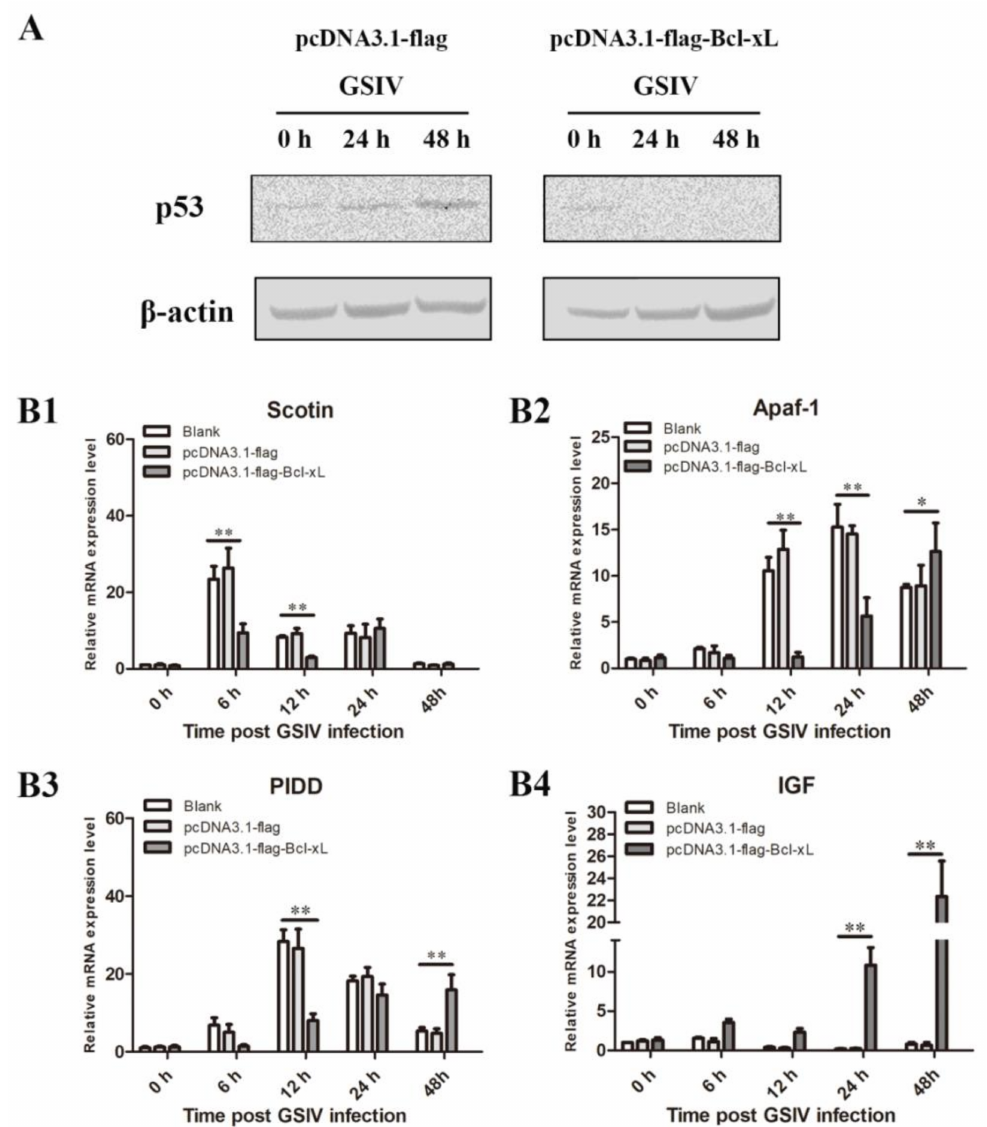
Figure 7. Ad Bcl-xL overexpression inhibited the p53 pathway during GSIV infection. ( A ) Proteins were extracted from GSM cells transfected with pCDNA3.1-flag-Bcl-xL or pCDNA3.1-flag and non- transfected cells (blank) after GSIV infection at the indicated time points and analyzed using Western blotting with β -actin as a reference. The mRNA expression patterns of p53 pathway genes, Ad Scotin ( B1 ), Ad Apaf-1 ( B2 ), Ad PIDD ( B3 ), and Ad GF ( B4 ), in GSM cells transfected with pCDNA3.1-flag-Bcl- xL or pCDNA3.1-flag and non-transfected cells (blank) were extracted after GSIV infection at the indicated time points. For convenience of comparison, the expression levels in the blank group at 0 h were set as 1. Error bars represent the mean ± SD; * p < 0.05, ** p <